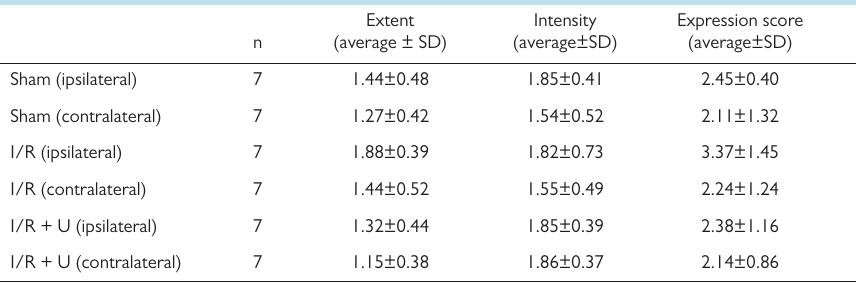
Table 2. Comparison of GPx expression score averages